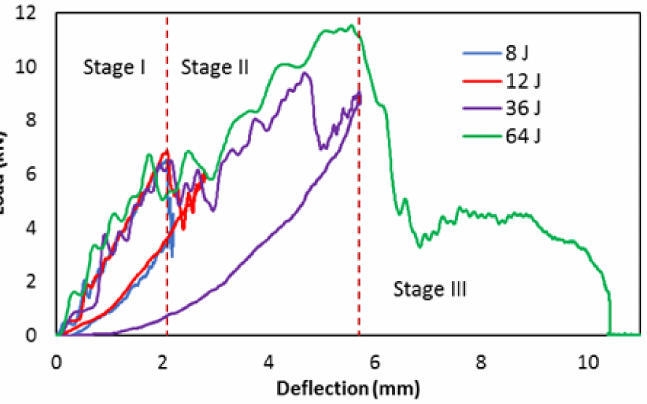
Figure 6. Comparisons of load-deflection plot generated from the drop-weight impact for the investigated laminates at different energy levels.